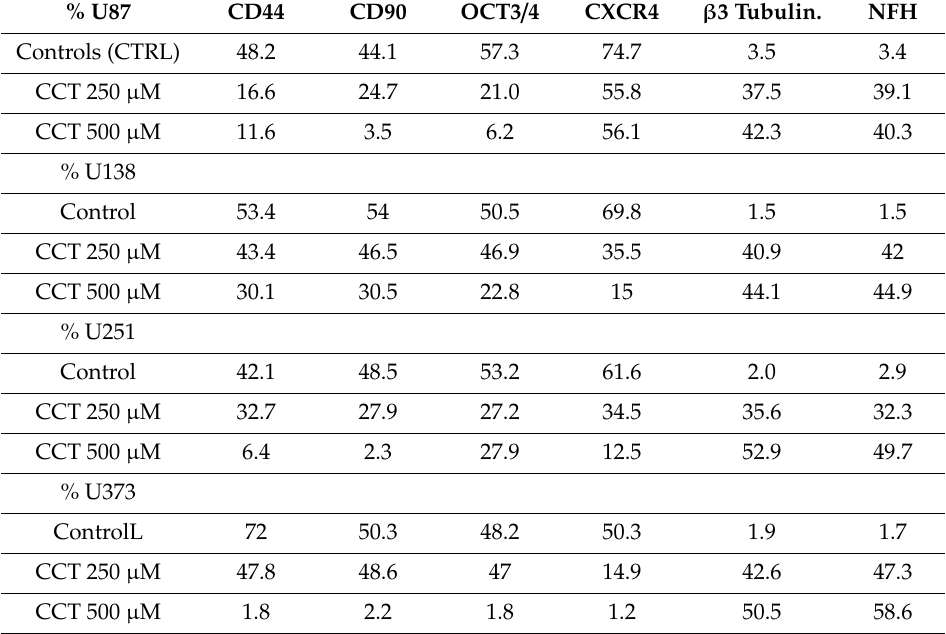
Table 1. Relative quantifications of the mesenchymal and neuronal markers in GBM cell lines as shown in Figure